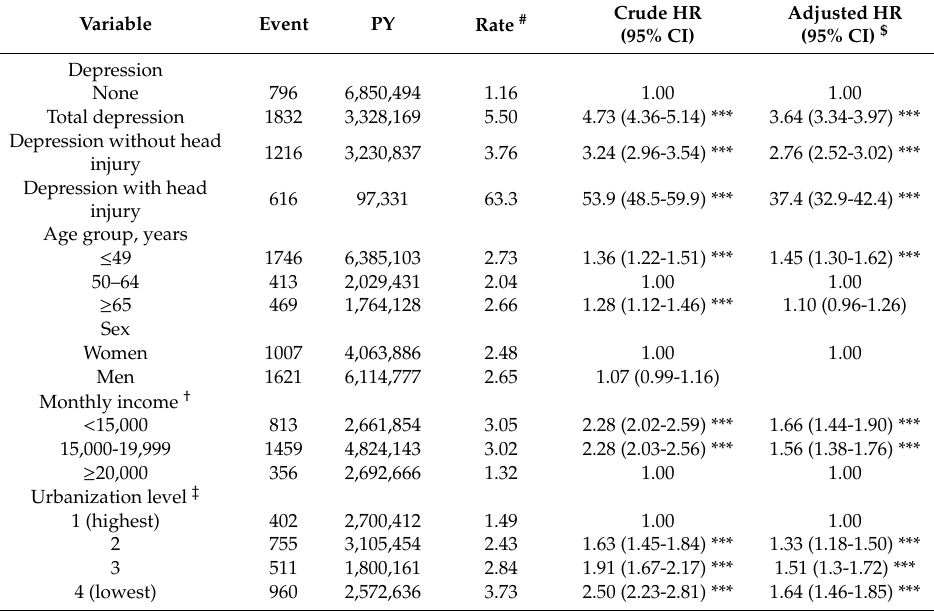
Table 2. Incidences and risk factors associated with various factors for suicide attempt.